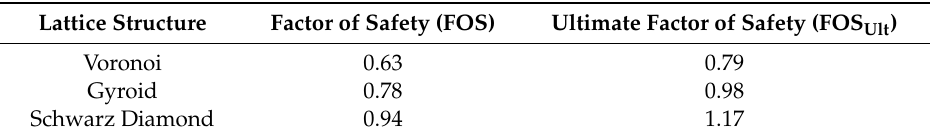
Table 5. Factor of safety for three di ff erent topology optimization approaches.